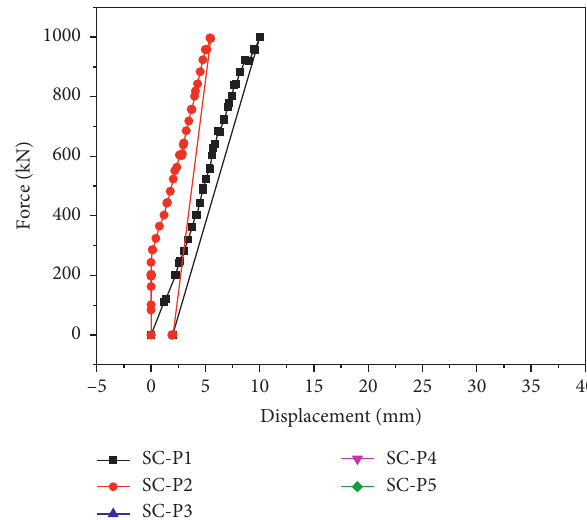
Figure 18: Load-midspan deflection curves of SC-P1 and